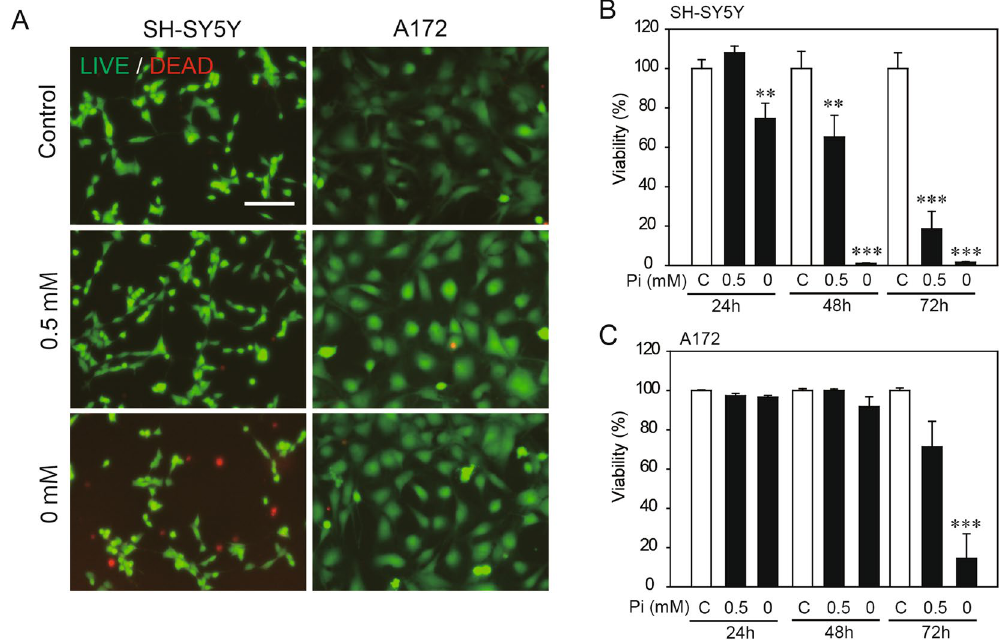
Figure 1. Effects of low Pi loading on cytotoxicity in SH-SY5Y or A172 cells. SH-SY5Y or A172 cells were cultured overnight in FBS-free/Pi-free DMEM. We then added appropriate amounts of sodium phosphate buffer to produce final Pi concentrations of 0, 0.5, and 1 mM (control concentration). For the cytotoxicity assays, the LIVE/DEAD Cell Imaging Kit ( A ) and Cell Count Reagent SF ( B , C ) were used in accordance with the manufacturer’s instructions. Data are represented as the mean ± SEM of three determinations, based on treatment with 1 mM Pi giving a viability of 100%. The significance of any difference was determined using ANOVA followed by the post-hoc Bonferroni/Dunn test ( ** p < 0.01, *** p < 0.001). Scale bar, 75 µ m in ( A